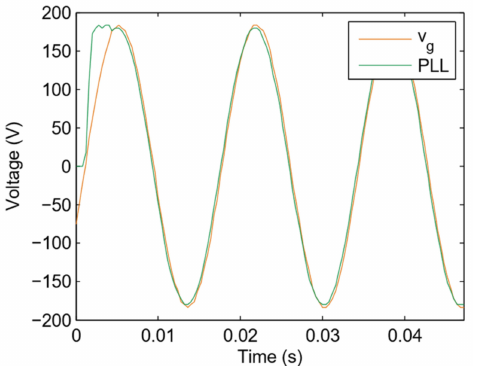
Figure 23. Comparison between the MG voltage and the reference signal of the Park